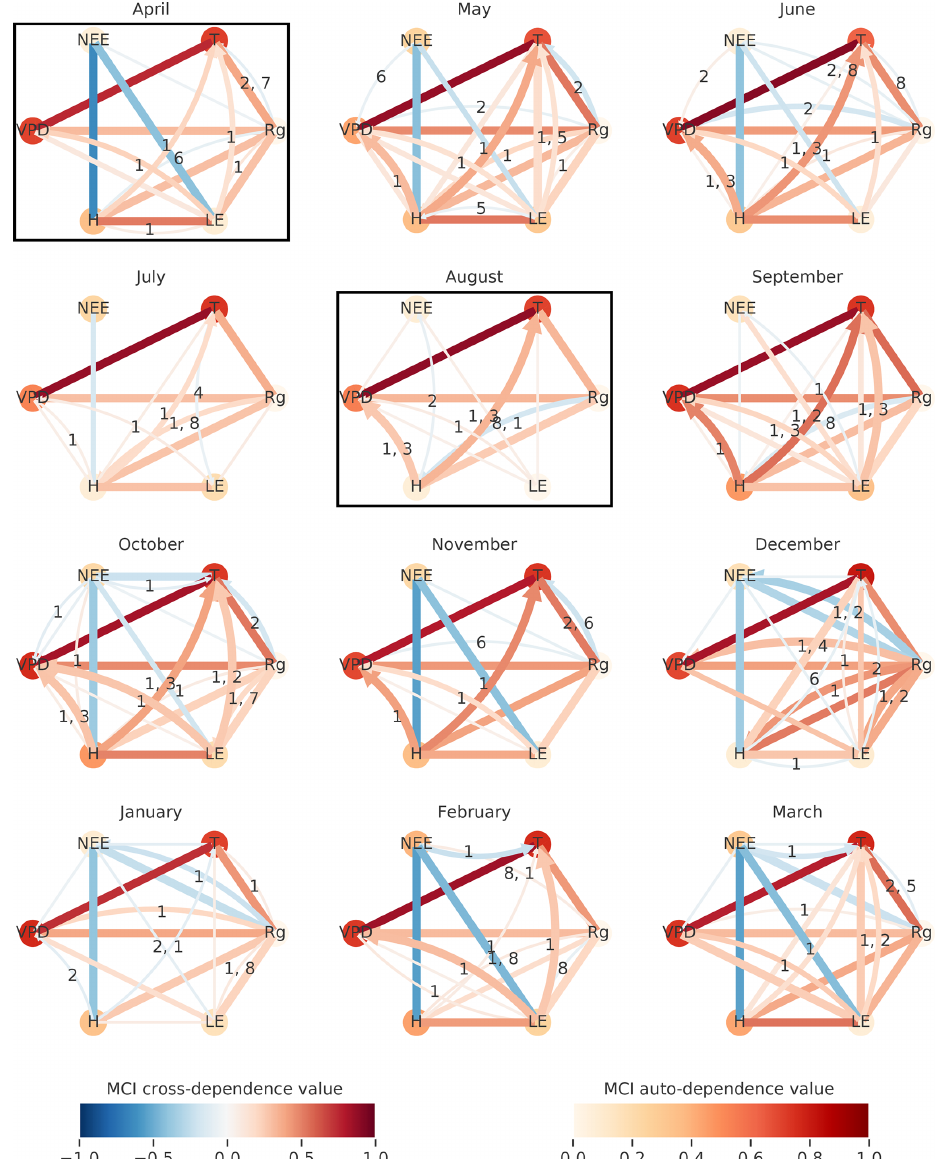
Figure 5. To visualise the gradual changes in interaction structure the networks of the three towers are combined for each month. The number of significant occurrences of a link is given by its width. The link strength, given by the link colour, is calculated by averaging the significant links of the towers. The link’s lag is shown in the centre of each arrow, sorted in descending order of link strength. The resulting graphs are shown for April 2014 until March 2015. The significance threshold is 0.01. The networks of April and August, illustrated in Fig. 4, are highlighted by a